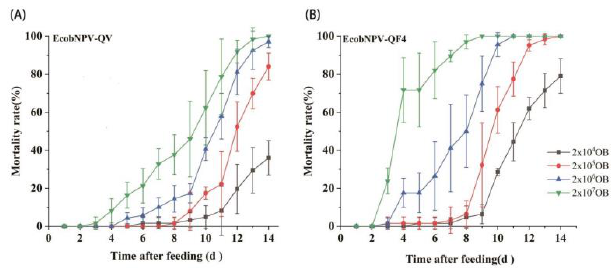
Figure 1. Death dynamics of E. grisescens feeding on leaves treated with EcobNPV-QV ( A ) and EcobNPV-QF4 ( B ). Twenty insects in each assay were tested per dose, with four replicates. Larvae feeding on distilled-water-treated leaves were used as control, to calculate the adjusted mortality-rate. Table 2. Comparison of the LD 50 , LT 50 and virulence between the two strains of EcobNPV for Ectropis grisescens . *LD 50 : Average doses (OBs) necessary to kill 50% of the larvae population in the test. **LT 50 : Average time (days) necessary to kill 50% of the larvae population in the test. Twenty insects were tested per dose in each assay, and four replicates were performed. Strain EcobNPV-QV EcobNPV-QF4 Number 254 260 Virulence regression equation y = −1.534 + 0.712x y = −2.638 + 1.107x Correlation coefficient R 0.9932 0.9653 LD 50 and 95% confidence inter-